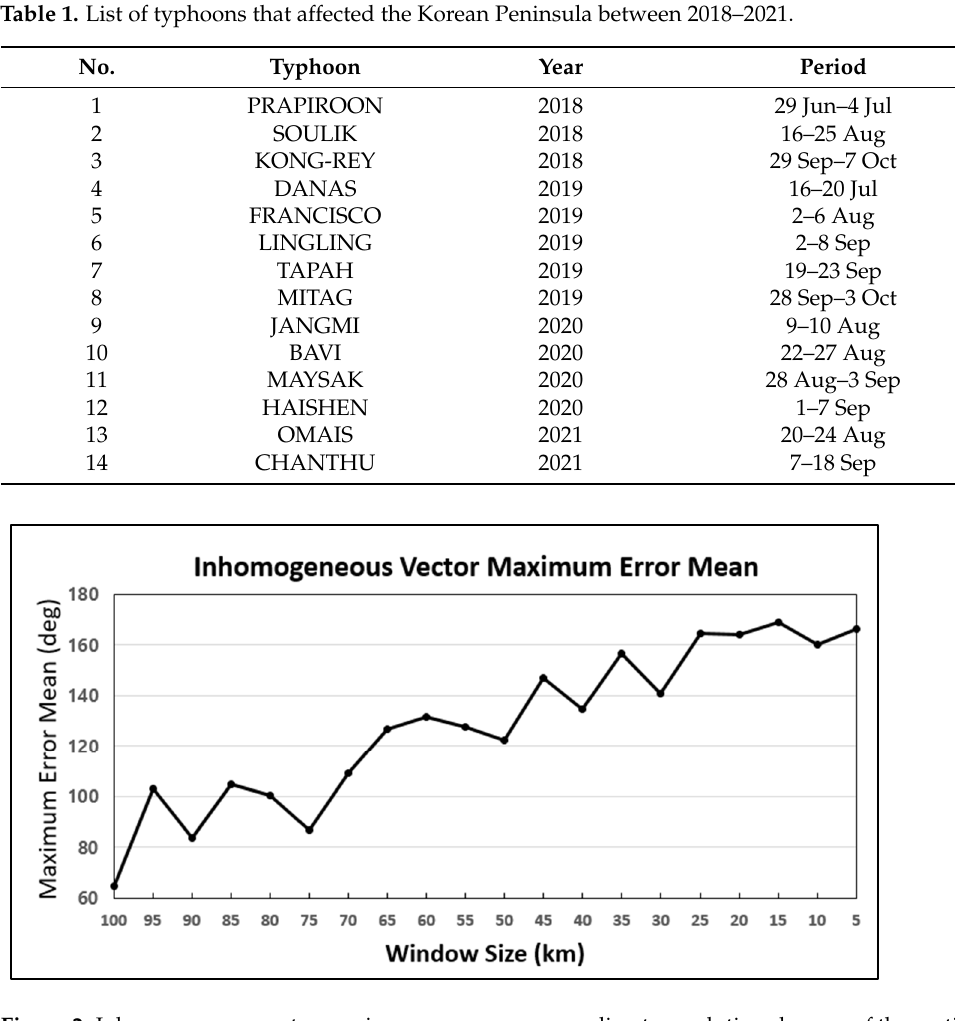
Figure 2. Inhomogeneous vector maximum error mean according to resolution changes of the motion vector calculation for 14 typhoon cases from 2018 to